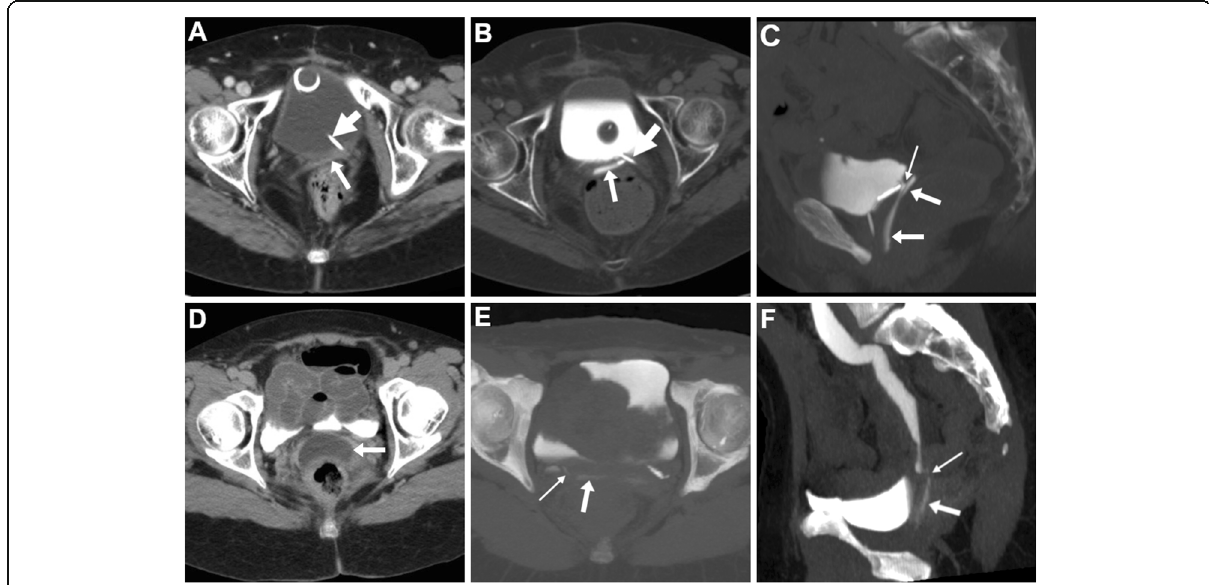
Fig. 15 Two cases of iatrogenic urinary VF. a – c After recent surgery for recurrent endometrial carcinoma, CT-urography (note ureteral stent indicated by thick arrows) shows left lateral retraction and opacification of the vagina (arrows) through a short vesico-VF (thin arrow in c ) [Adapted from Open Access Ref. no. [25]]. d – f Following radical hysteroannessectomy for endometrial carcinoma, CT-urography shows marked fluid-filled dilatation of the vagina (arrow in d ). On ultra-delayed (30 min) acquisition ( e , f ), some opacified urine flows into the vagina (arrows) through a leaking uretero-VF (thin